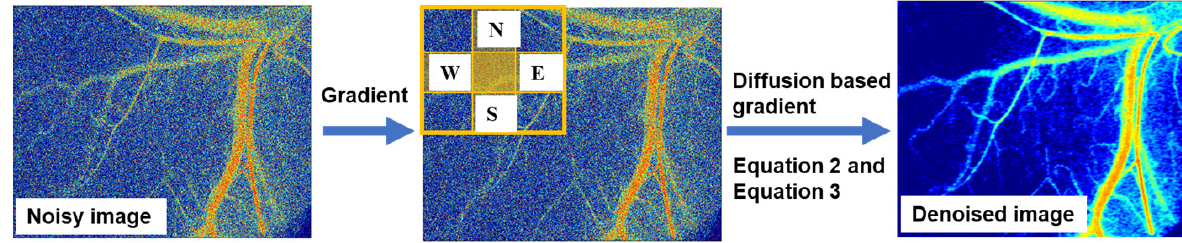
Figure 5. The tLSCI with the ADF